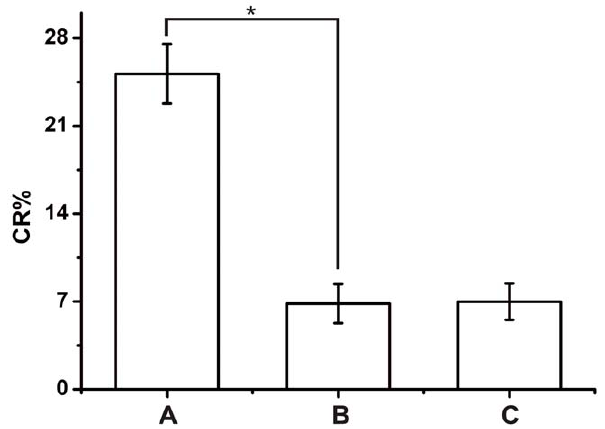
Figure 8. Application of E18R-42/PCDA vesicles in fecal samples contaminated artificially (10 8 CFU/ml initial concen- tration of E . coli O157:H7). (A) CR% of E18R-42/PCDA vesicles with artificially contaminated fecal samples. (B) CR% of E18R-42/PCDA vesicles with uncontaminated fecal samples. (C) CR% of pure PCDA vesicles with artificially contaminated fecal samples. *, p , 0.05 by Student’s t test.